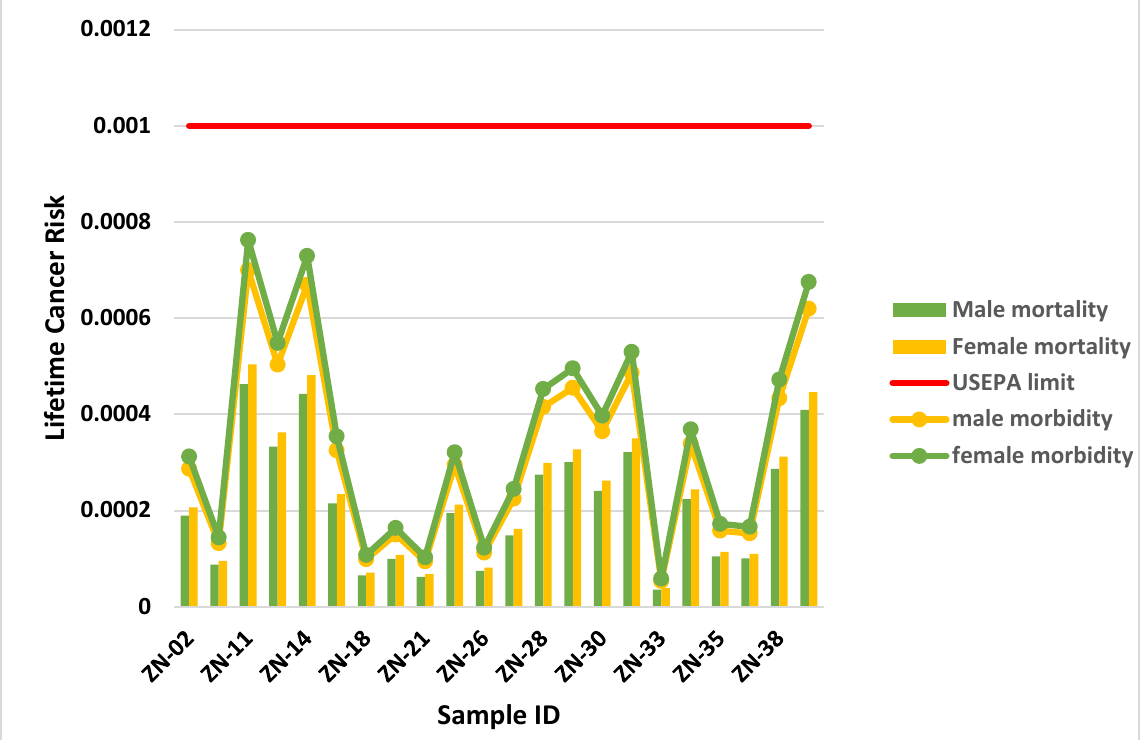
Figure 9. Mortality and morbidity risks of cancer ( 238 U related) from the ingestion of drinking water from the West Rand.